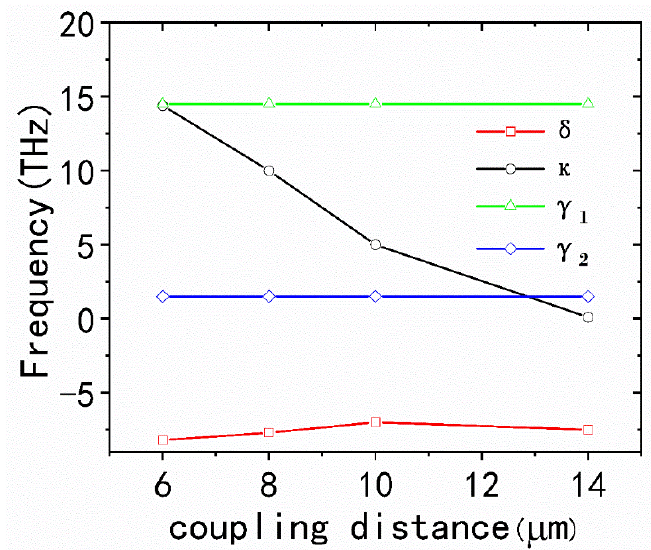
Figure 5. The fitting parameters γ 1 , γ 2 , δ and κ as a function of the coupling distance between the  ,  ,  and  as a function of the coupling distance between the graphene CW resonator and graphene Figure 5. the fitting parameters 1 2 graphene CW resonator and graphene SRRs.